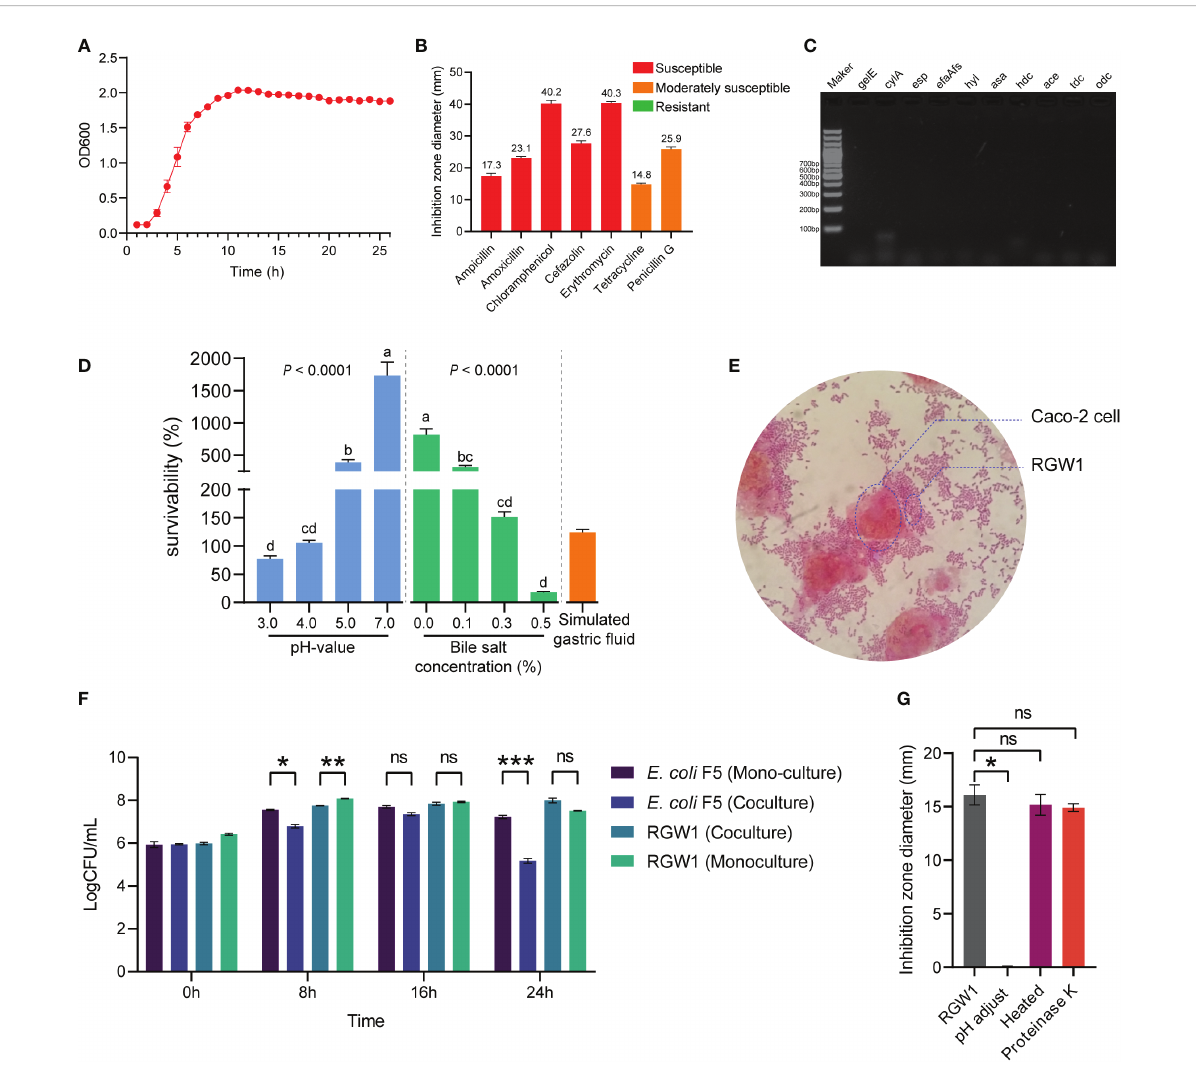
FIGURE 2 In vitro probiotic characteristics of L. reuteri RGW1. (A) The growth kinetics of L. reuteri RGW1. (B) Antibiotic susceptibility pro fi le of L. reuteri RGW1 is indicated by the diameters of inhibition zone, the “ S ” represents sensitivity. (C) Agarose gel electrophoresis results of virulence gene PCR products. (D) Survivability of L. reuteri RGW1 at different pH values (blue), bile salt concentrations (green), and in simulated gastric fl uid (orange), a-d represent different superscripted letters (P < 0.05). (E) Representative image of the coculture of L. reuteri RGW1 with Caco-2 cells stained with safranin O solution. (F) Monoculture or coculture of L. reuteri RGW1 with E. coli F5. Each bacterial concentration was counted at 0, 8, 16, 24 h of culture, respectively. (G) The anti E. coli F5 activity of L. reuteri RGW1 indicated by the diameters of inhibition zone, after different pretreatments. Values are expressed as means ± SEM. *P < 0.05; **P < 0.01; ***P < 0.001; ns, not signi fi